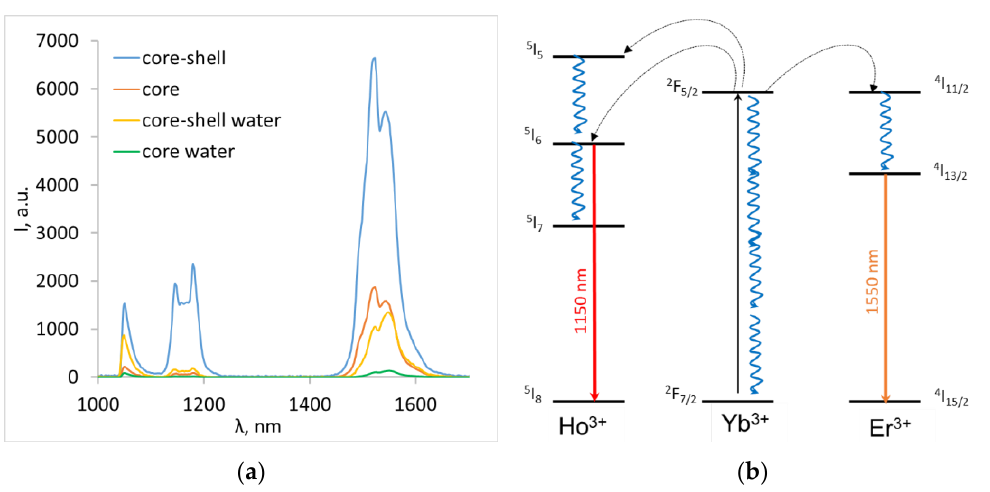
Figure 3. The influence of pump power density on heating temperature of ( a ) core NaGdF 4 :Yb 3+ , Ho 3+ , Er 3+ NPs and ( b ) core-shell NaGdF 4 :Yb 3+ , Ho 3+ , Er 3+ NPs.